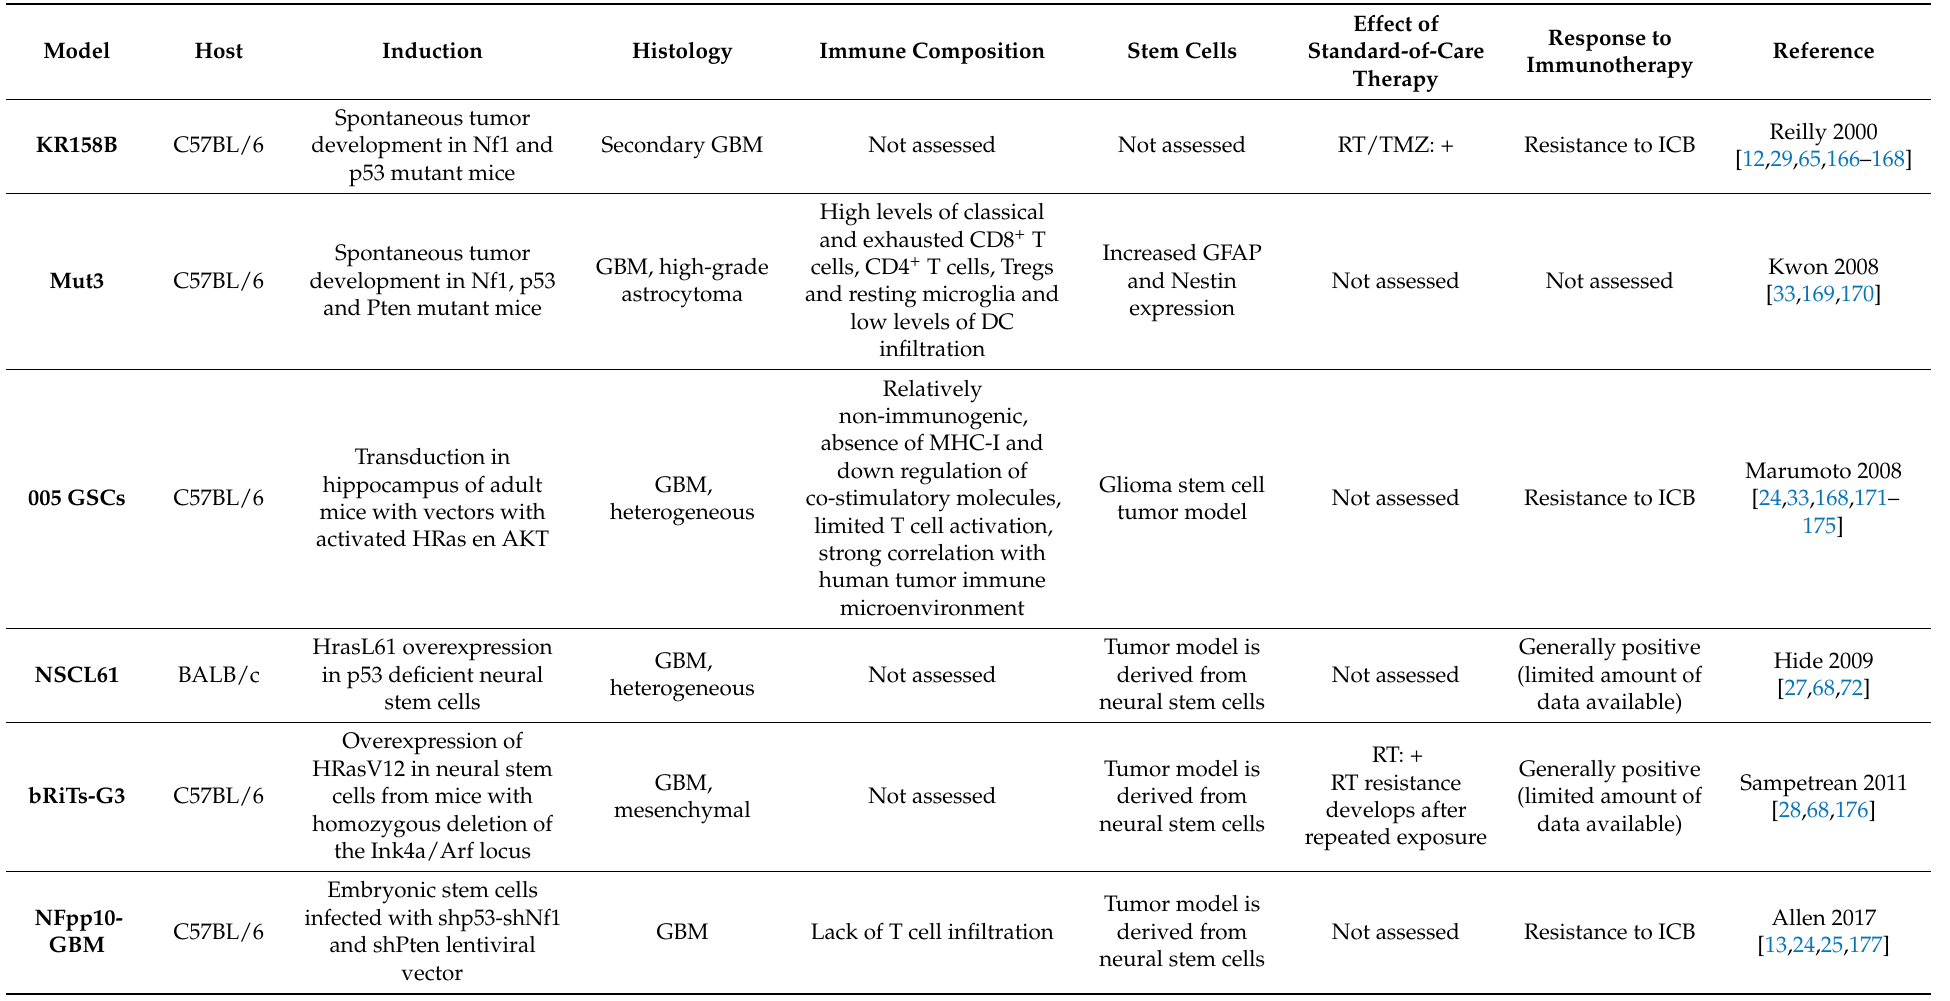
Table 2. Overview of the different characteristics of the KR158B, Mut3, 005 GSCs, NSCL61, bRiTs-G3, NFpp10-GBM, NS/CT-2A, SB28 and mGB2 mouse models.